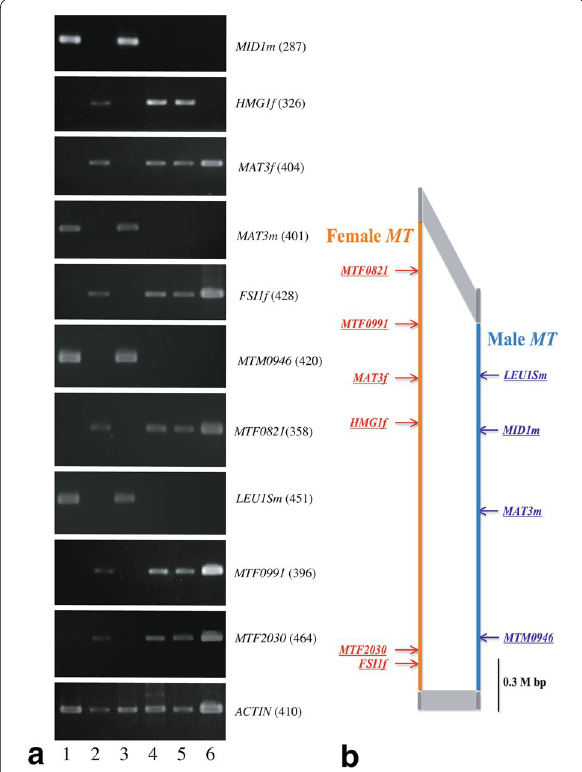
Fig. 4 Mating‑type locus ( MT ) genes of Volvox carteri f. nagariensis . a Results of genomic PCR of five Taiwanese strains (lanes 1–4 and 6) and Eve (UTEX 1885) (lane 5) using primers listed in Table 2. Numbers within the parentheses just right to the gene designations represent expected lengths of the PCR products. Lane 1: 2016‑tw‑nuk‑6‑1. Lane 2: 2016‑0609‑v‑1. Lane 3: 2016‑0610‑v‑11. Lane 4: 2016‑tw‑nuk‑Chg. Lane 6: 2016‑tw‑nuk‑8‑2. Note that both male genes and HMG1f were not amplified in 2016‑tw‑nuk‑8‑2. b Diagram showing positions of sex‑specific and sex‑based divergent genes in the mating‑type locus analyzed by genomic PCR in ( a ). Based on Ferris et al.